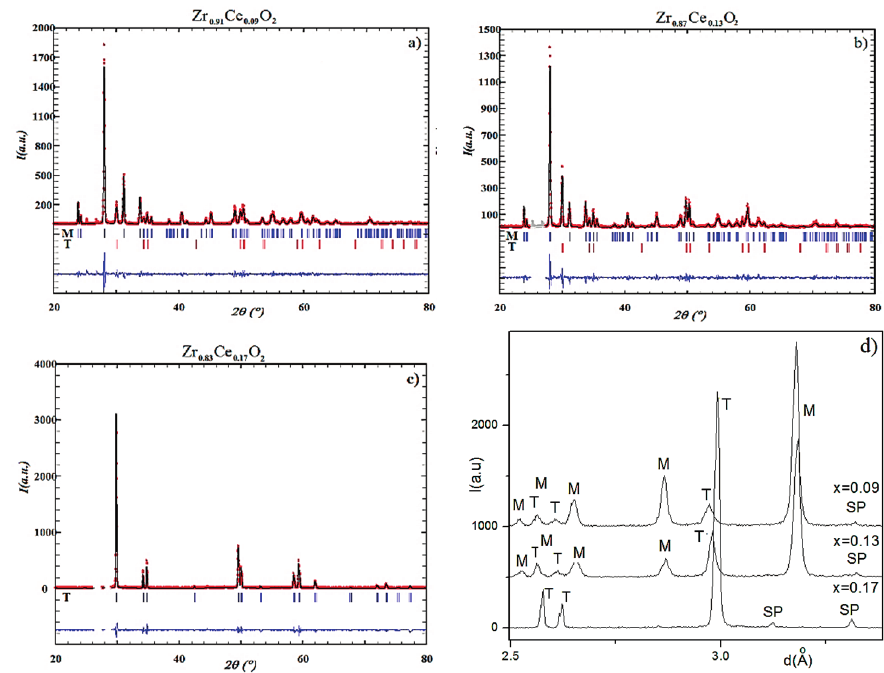
Figure 7. X-ray diffractograms corresponding to ( a ) x = 0.09; ( b ) x = 0.13; ( c ) x = 0.17; ( d ) difractograms presenting the dependence of intensity (I) on interplanar distances ( d ) and Ce concentration ( x ). The vertical bars correspond to the monoclinic (M) and tetragonal (T) phases (FullProf program was used for determination of parameters). SP represents the foreign